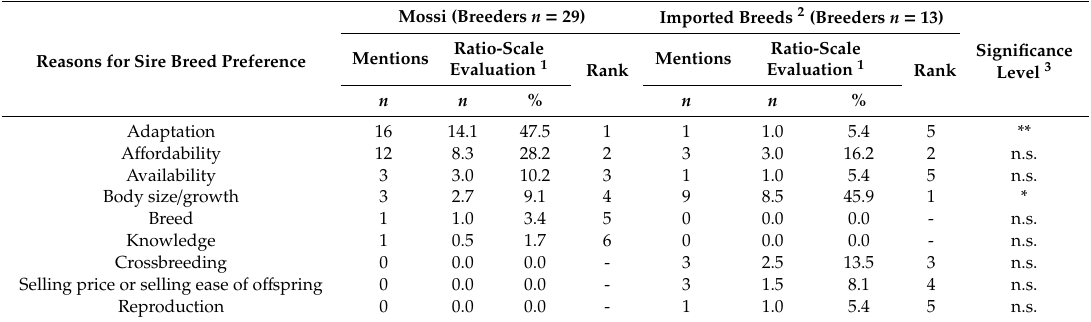
Table 6. Preferences for local and imported sire breeds used by sheep breeders in